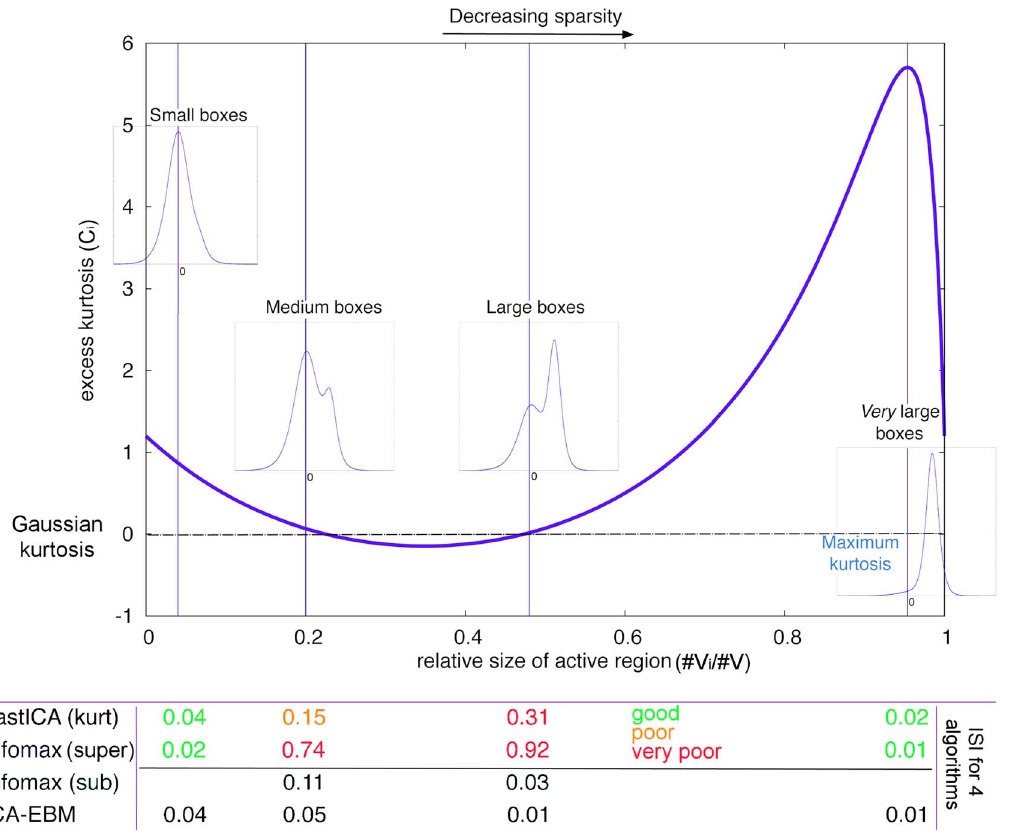
Figure 1. The excess kurtosis of a source C i as a function of the relative size of the active region. A Gaussian has zero excess kurtosis. { 1 as in Example 2 of the original paper [8]. The four vertical lines at correspond to the relative sizes of the small box, the Here W x ~ 1 z e 2 2 { u ð Þ (cid:2) (cid:3) medium box, the large box, and a very large box corresponding to the maximal kurtosis case. Note that the medium and large box experiments have near zero excess kurtosis, i.e., kurtosis value matching that of a Gaussian . In addition, the pdfs of these sources are bimodal (see inset figures), ensuring that ICA algorithms designed for unimodal super-Gaussian distributions such as Infomax and FastICA with standard parameter settings, will likely fail. At the bottom of the figure are the ISI values (see Equation (2)) for the various algorithms at those four points (see Table 1 for full list). Also note the best separation performance of Infomax and FastICA for the maximum kurtosis case, which corresponds to almost the lowest level of sparsity.